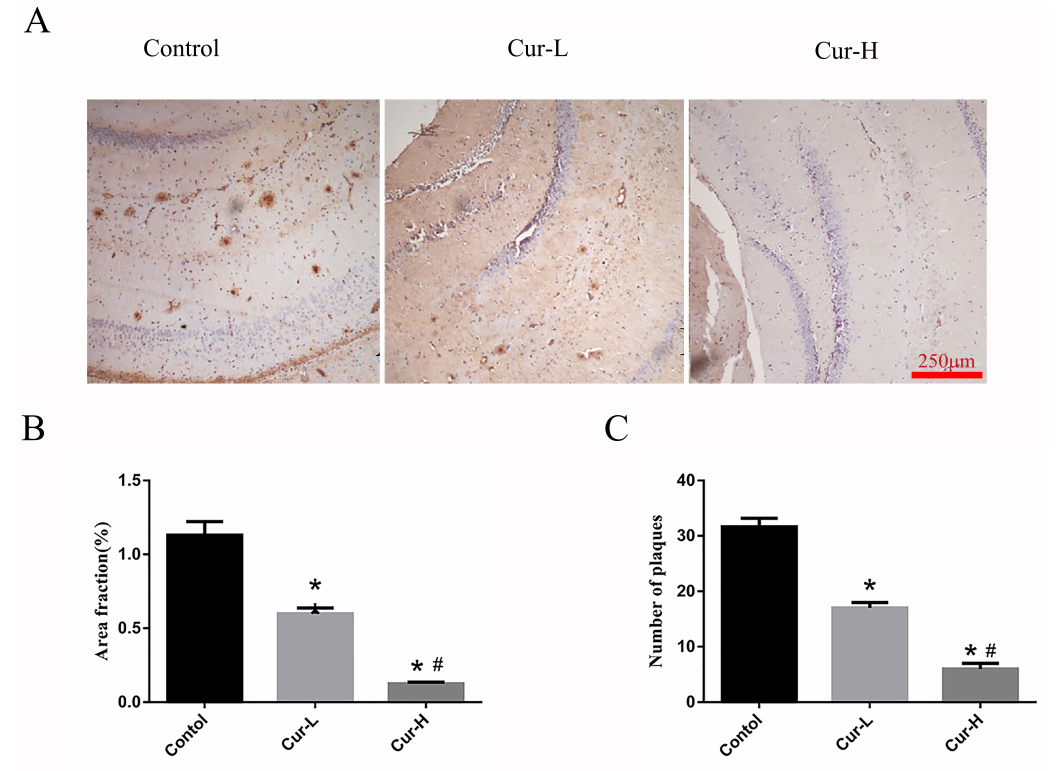
Fig. 2. Curcumin reduced A β in the hippocampus of APP/PS1 mice. (A) Immunohistochemical staining displays amyloid protein was expressed in the hippocampus of different groups (Scale bar = 250 µ m). (B,C) Area fraction and number of plaques of A β in every group (# p < 0.05, versus Cur-L; * p < 0.01, versus Control).